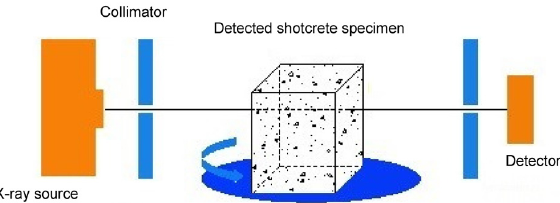
Fig. 8. X-ray CT scanning system